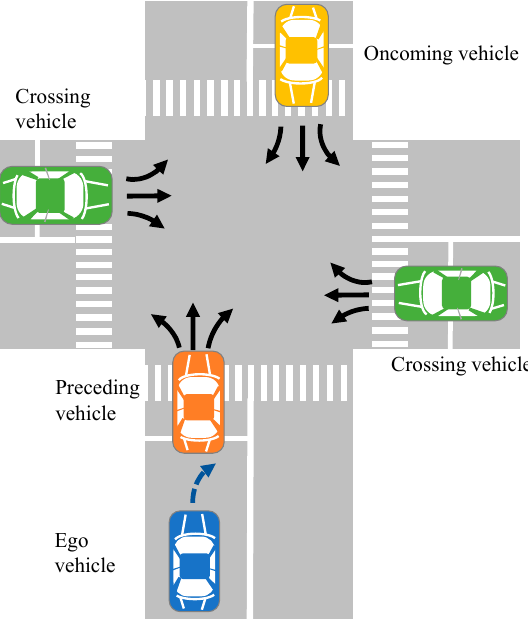
Figure 3. Ego vehicle and other vehicles.